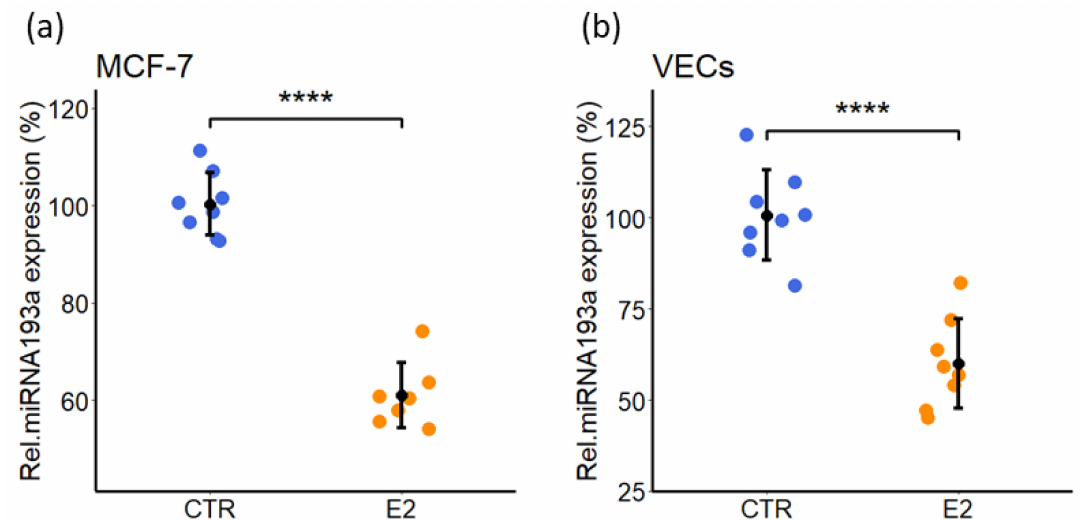
Figure 11. Estradiol (E2) downregulates miRNA193a-3p expression in MCF-7 and VECs. Starved cells (MCF-7 or VECs) were treated for 72 h with 10 nM E2. Subsequently, total RNA was extracted and relative miRNA193a expression levels quantified by RT-PCR using TaqMan miRNA assay. E2 significantly downregulates miRNA193a expression in MCF-7 cells ( a ) and VECs ( b ). The results were normalized to U48 and U49. Results represent mean ± SD; n = 3. p < 0.001 **** compared to the respective control.